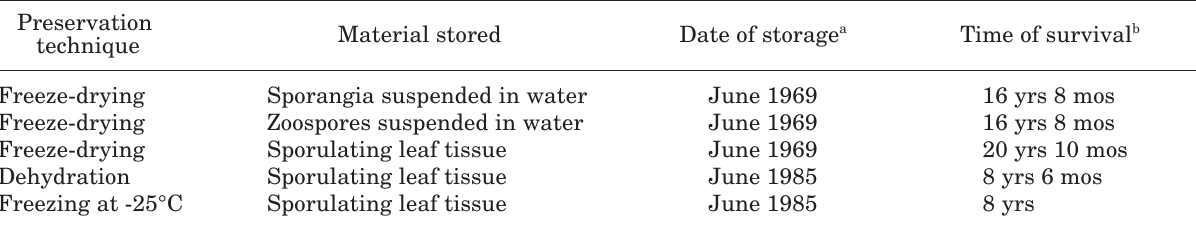
Table 1. Survival of Plasmopara viticola after storage by three